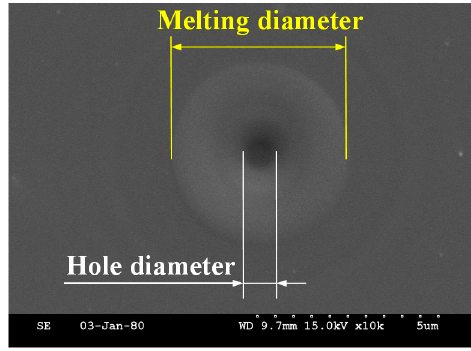
Figure 11. SEM picture of a machined hole with power density of 1.2  10 8 W/cm 2 at 12 ∘ C for 20 s. Figure 10. Enlarged SEM pictures of machined holes with 12 ∘ C for 20 s. Figure 10. Enlarged SEM pictures of machined holes with 12 ∘ C for 20 s.